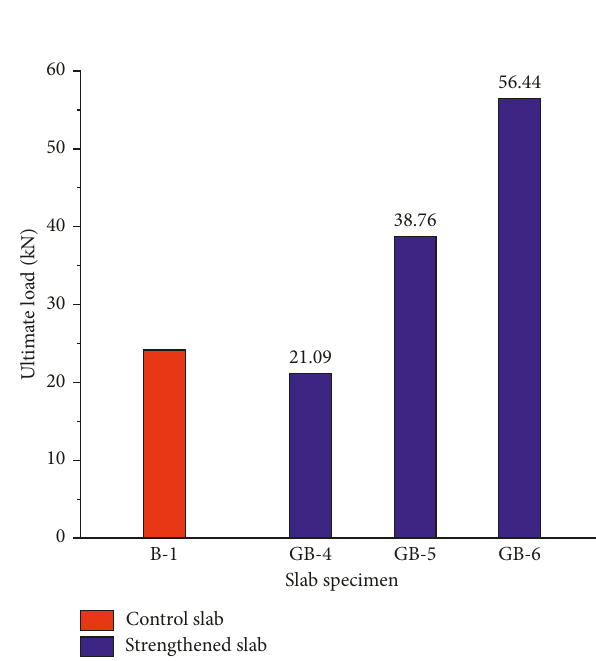
Figure 43: Midspan cracking